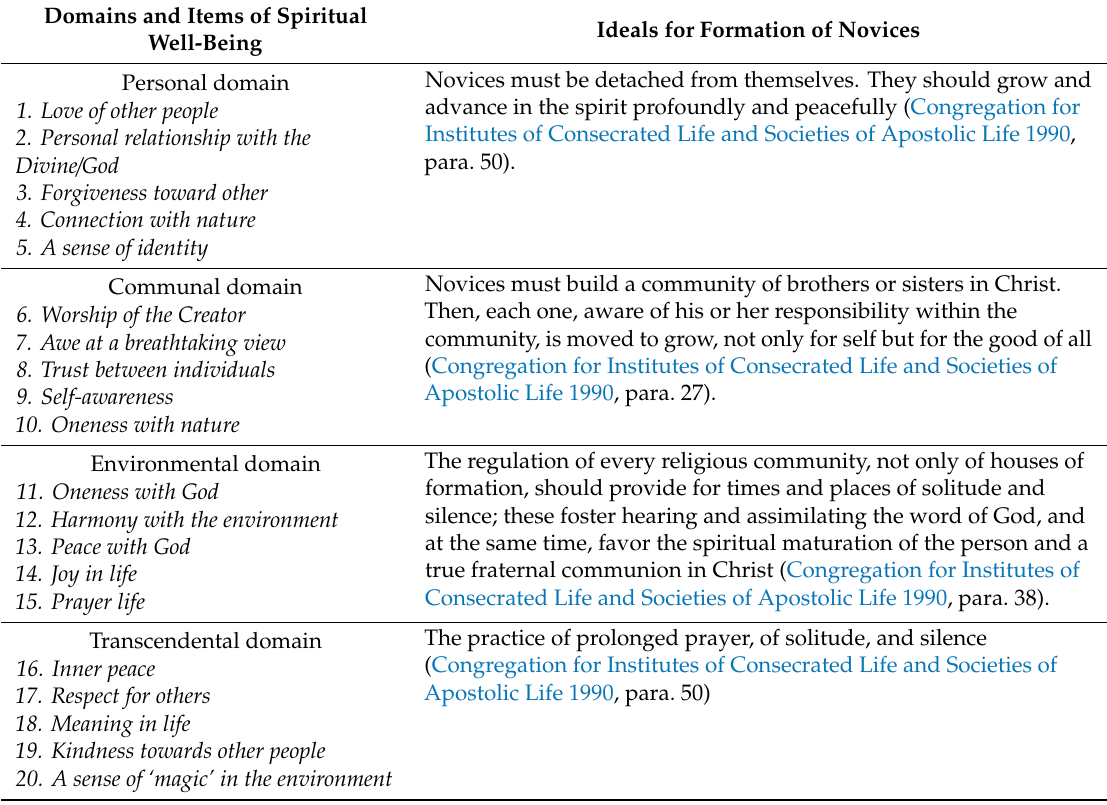
Table 1. Domains and Items of Spiritual Well-Being and Ideals for Formation of